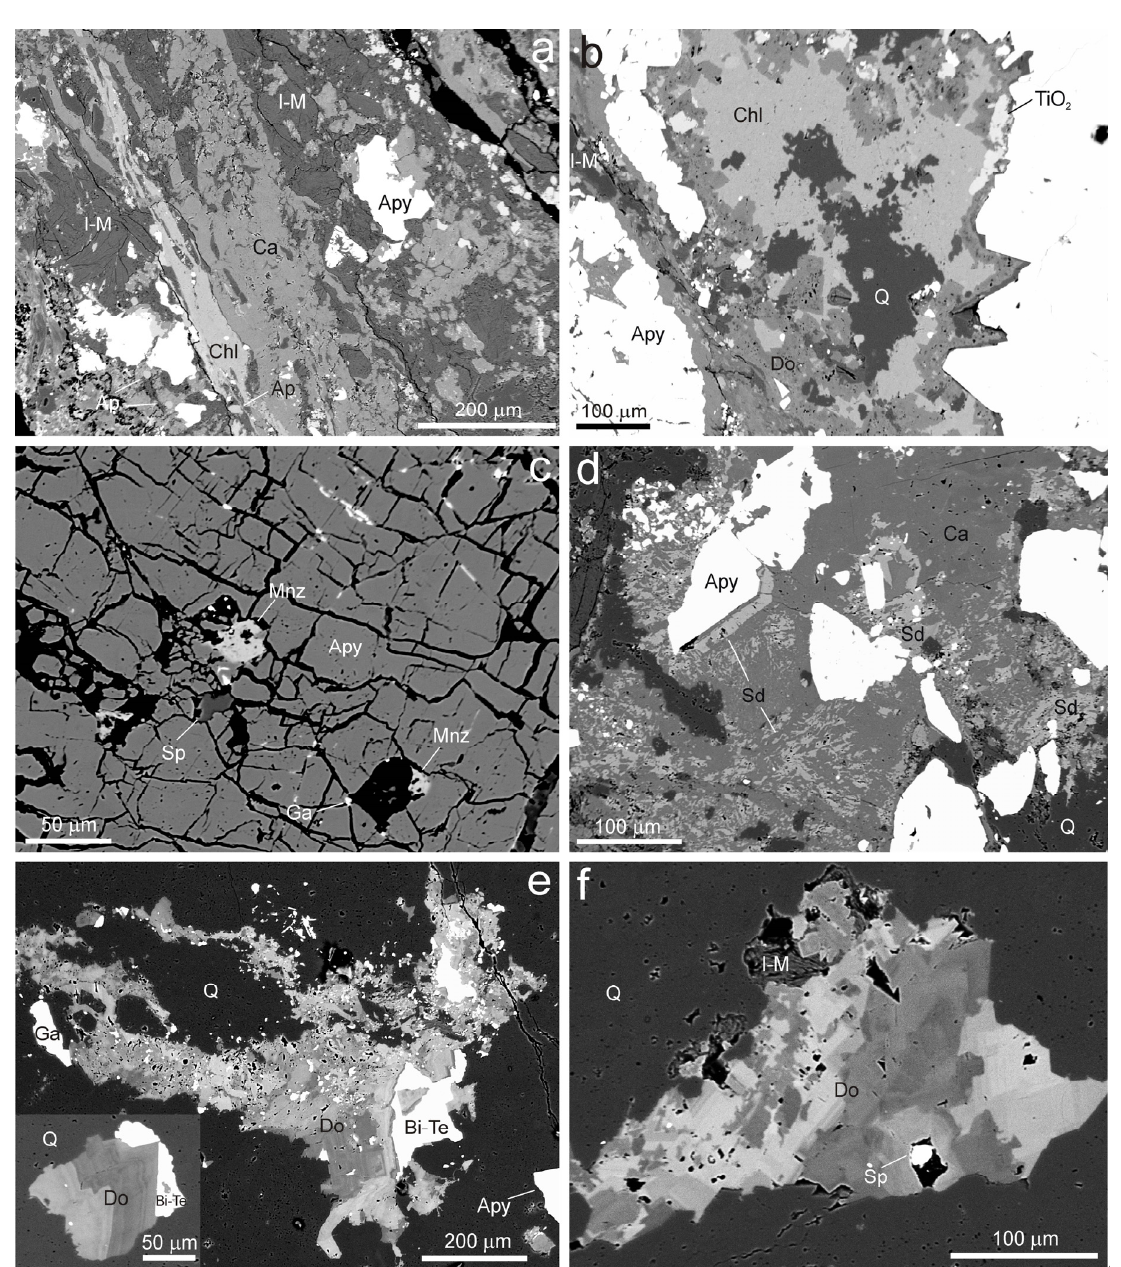
Figure 5. Gangue minerals of the studied Au-bearing vein in BSE images: ( a ) The oldest portion of vein fill composed of illite–muscovite (I–M), chlorite (Chl), calcite (Ca), apatite (Ap), and arsenopyrite (Apy). ( b ) Zonal aggregate composed of chlorite (Chl) and dolomite–ankerite (Do) developed around quartz (Q) with minor TiO 2 phase (TiO 2 ) and illite–muscovite (I–M). ( c ) Cracked arsenopyrite (Apy) with crack-hosted grains of monazite (Mnz), sphalerite (Sp), and galena (Ga). ( d ) Siderite (Sd) and quartz (Q) strongly corroded by calcite (Ca). ( e ) Nest of strongly zoned dolomite–ankerite (Do) hosted by quartz (Q) and containing aggregates of Bi-tellurides (Bi-Te), which are sometimes clearly younger than euhedral crystals of dolomite–ankerite (inset). ( f ) Nest of complexly zoned dolomite–ankerite (Do) hosted by quartz (Q) and illite–muscovite (I–M) gangue. The vug in dolomite–ankerite contains a grain of sphalerite (Sp).